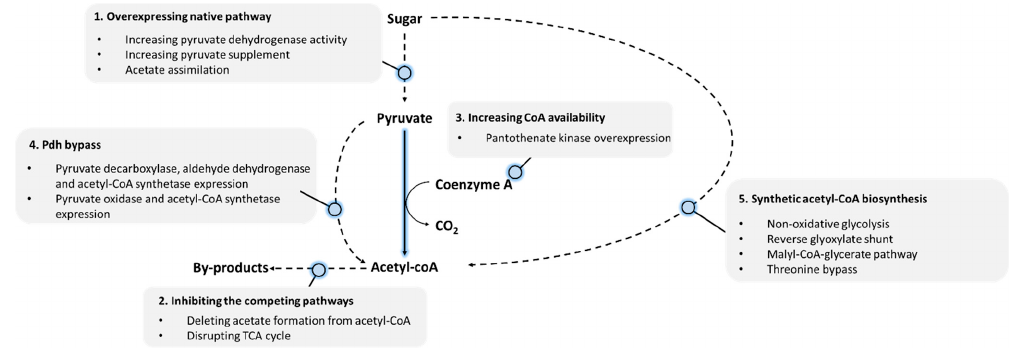
Figure 1. Summary of strategies for increasing acetyl-CoA flux and concentration in Escherichia coli .